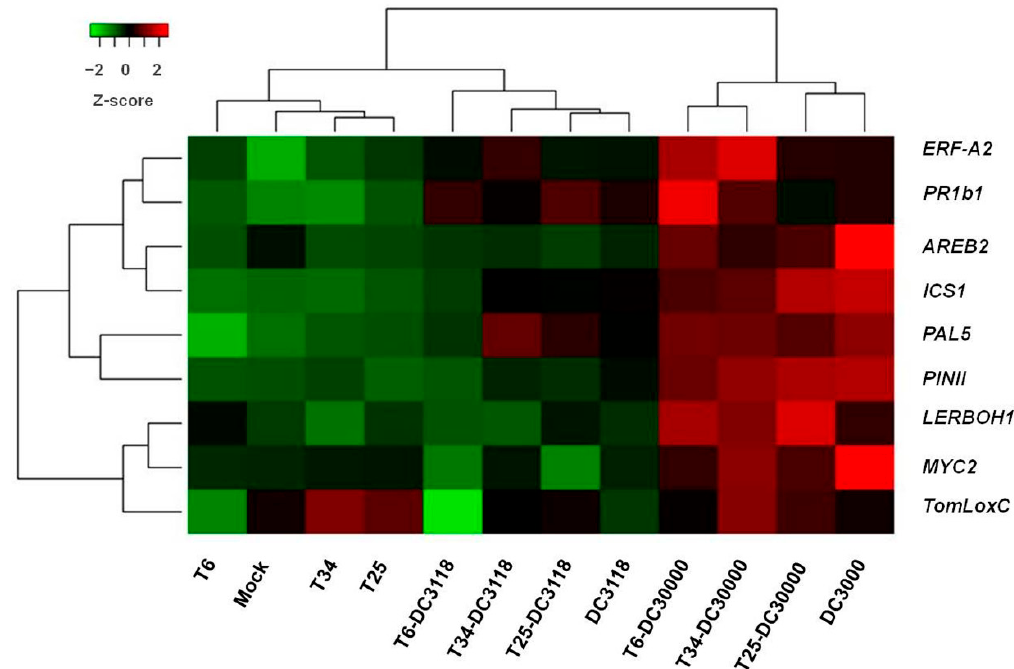
Figure 4. Two-way hierarchical clustering analysis of the normalized expression level of the nine genes evaluated in this study and the 12 treatments considered. Low gene expression values are green, and high gene expression values are red. The distance matrix was calculated using the Ward’s linkage method and the Euclidean distance, and R programming tools were used to visualize the matrix.